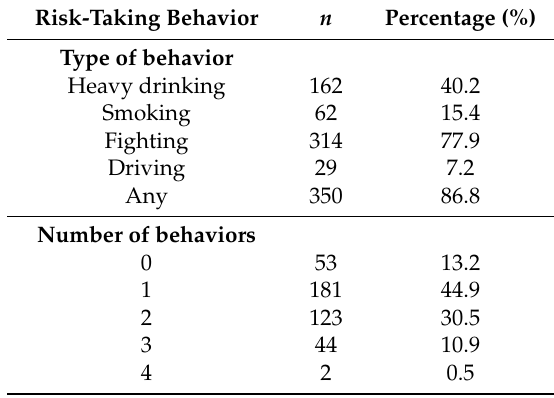
Table 1. The proportion of veterans engaging in each category of